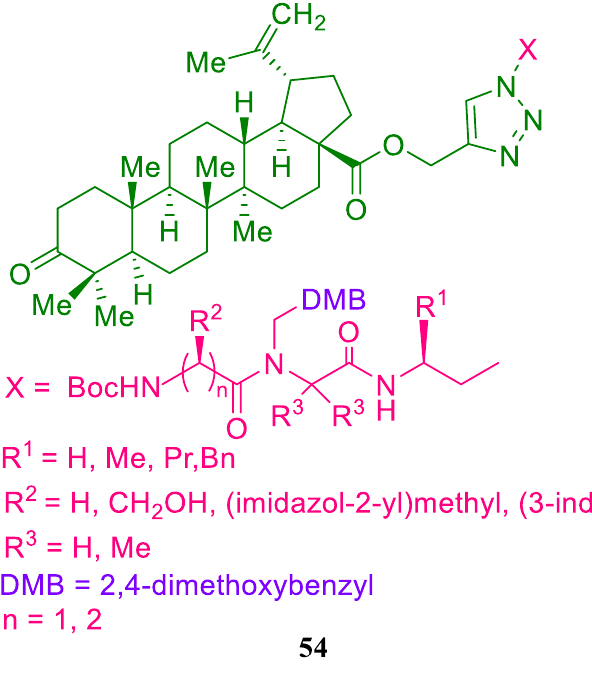
Figure 49. Peptides conjugated to betulonic acid derivatives.